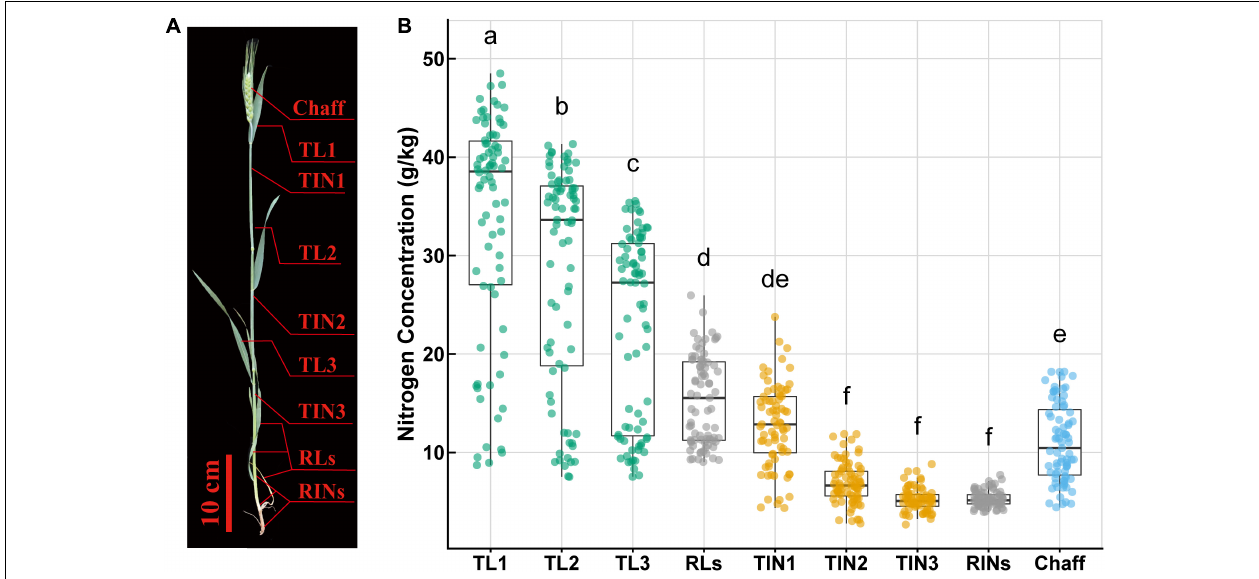
FIGURE 1 | Schematic of wheat plant organs (A) and nitrogen concentration ( N mass ) variation (B) within and among these organs. The different lowercase letters above the boxplot show significant different mean value ( p < 0.05). TL1, top first leaf; TL2, top second leaf; TL3, top third leaf; RLs, remaining leaves; TIN1, top first internode; TIN2, top second internode; TIN3, top third internode; RINs, remaining internodes.